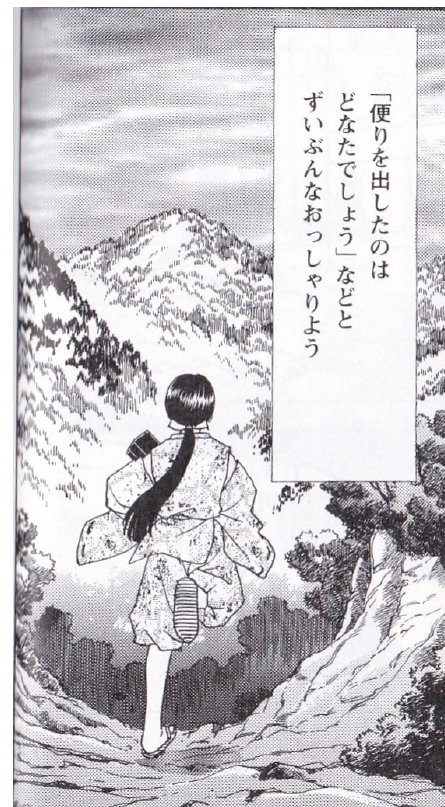
Figure 9. A boy delivers letters between the capital and Ishiyama-dera